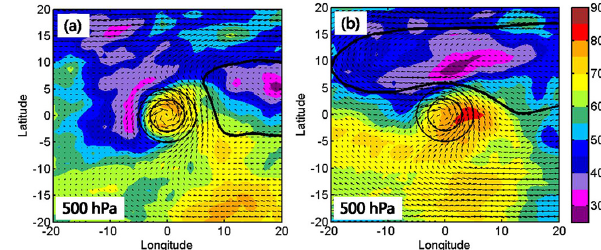
Figure 3. GFS-derived fields for the composites of RH (shading, 5% intervals starting at 25%), vector winds at 400 hPa, and geopo- tential height of 5880m at 500hPa (thick black line) for (left) weak- ening and (right) strengthening events at time t − 12h . The two black solid circles are 3 ◦ - and 5 ◦ -radius circles centered on the storm.